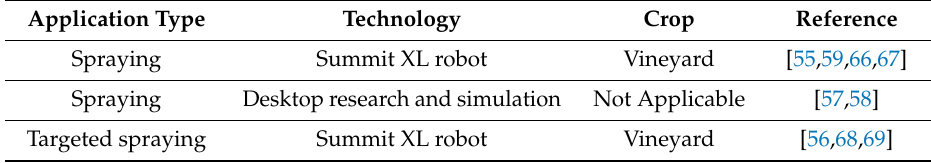
Table 1. Robotics applications in Cyprus